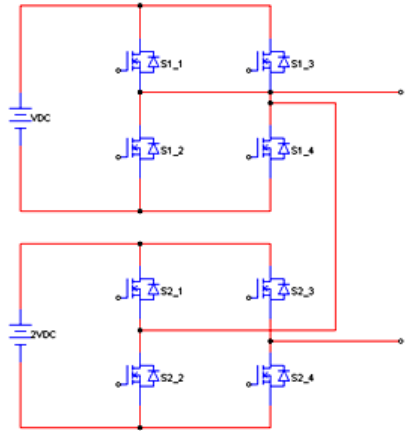
Figure 7. Seven-level cascaded type H-bridge MLI.